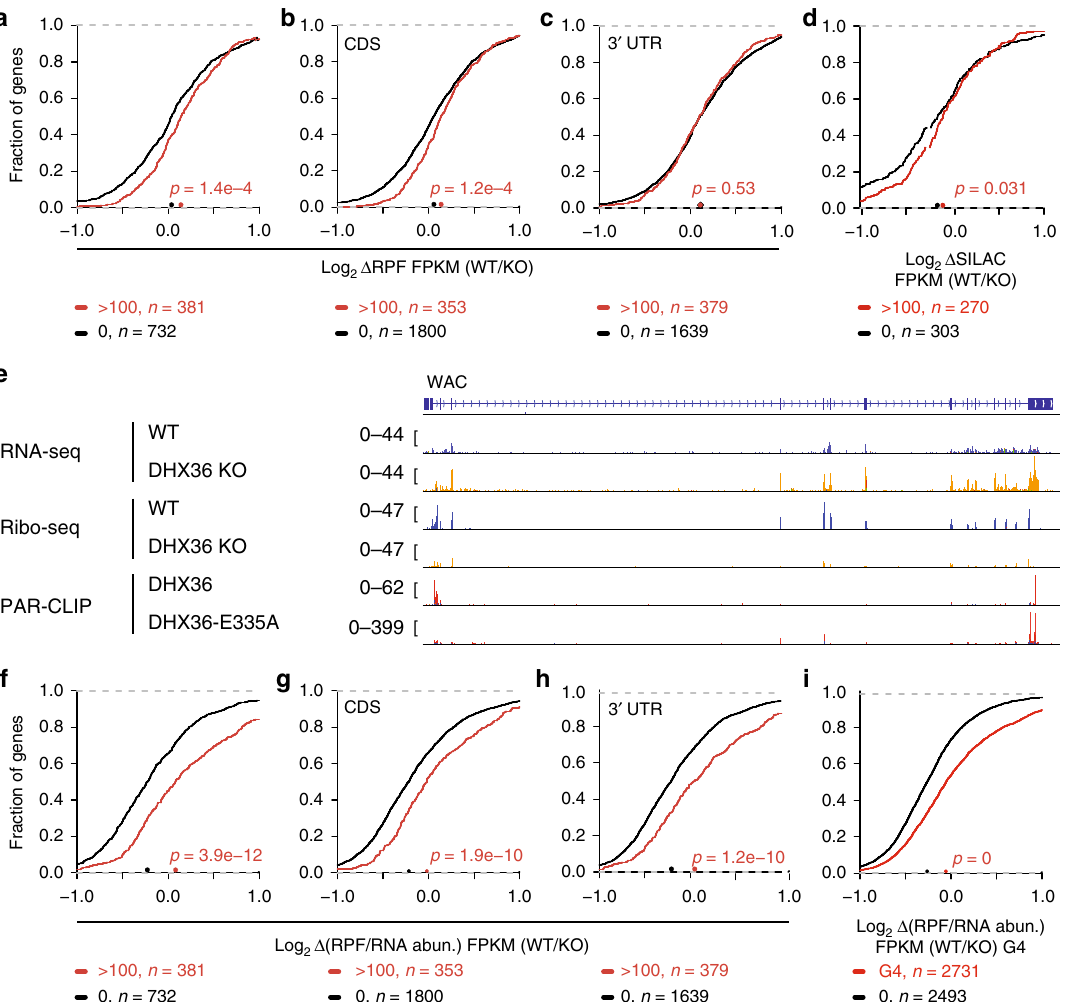
Fig. 5 DHX36-KO results in reduced target mRNA translation ef fi ciency. a Cumulative distribution function comparing changes in ribosome-protected fragments (RPFs) of DHX36-KO ( n = 3) and parental HEK293 cells ( n = 3). Target mRNAs are binned in accordance to the number of NXPM obtained by DHX36-E335A PAR-CLIP. Signi fi cance was determined using a two-sided KS test. b Same as in a , except target mRNAs were binned in accordance to NXPM in the CDS. c Same as in a , except mRNAs were binned based on the number of NXPM in the 3 ′ UTR. d Same as in a , except protein abundance changes as determined by SILAC were plotted. e Screenshot of RNA-seq and Ribo-seq coverage in wild-type and DHX36-KO HEK293 cells on the representative DHX36 target WAC. Bottom two tracks show the coverage for DHX36 and DHX36-E335A PAR-CLIP. f Cumulative distribution function comparing changes in translation ef fi ciency (TE, RPF/RNA abundance) of DHX36-KO ( n = 3) and parental HEK293 cells ( n = 3). Target mRNAs are binned in accordance to the number of NXPM obtained by DHX36-E335A PAR-CLIP. Signi fi cance was determined using a two-sided KS test. g Same as in f , except mRNAs were binned based on the number of NXPM in the CDS. h Same as in f , except mRNAs were binned based on the number of NXPM in the 3 ′ UTR. i Same as in f , except mRNAs were binned based on whether they harbor a G4-site identi fi ed previously 10 overlapping with PAR-CLIP binding sites or